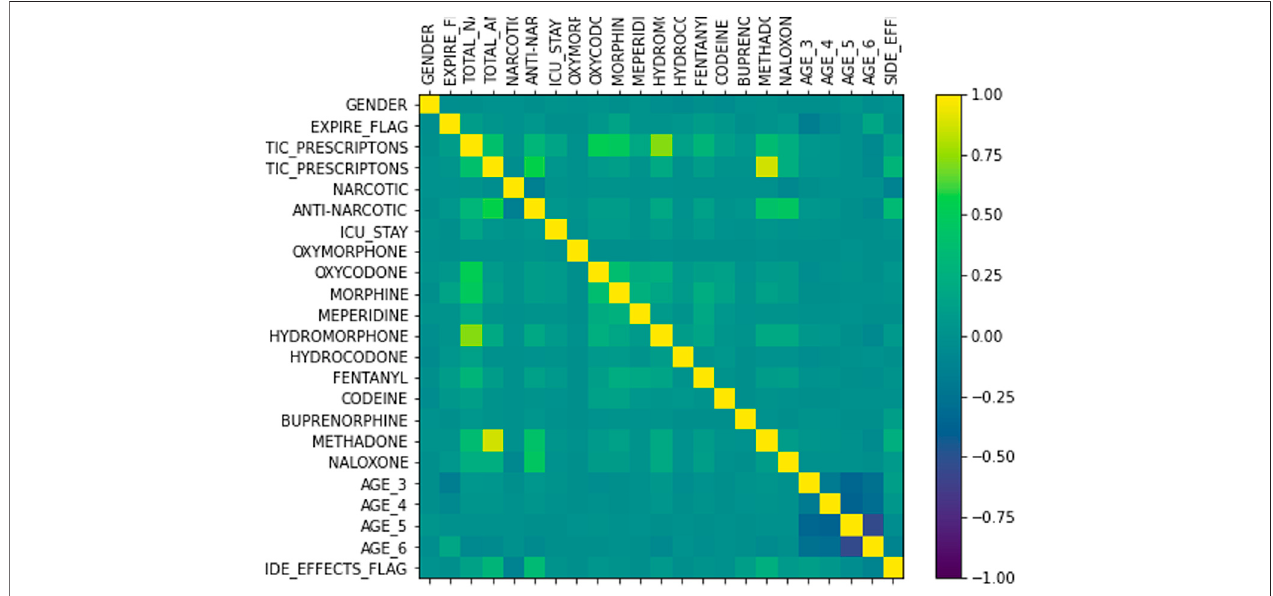
FIGURE 1 | Correlation of features.